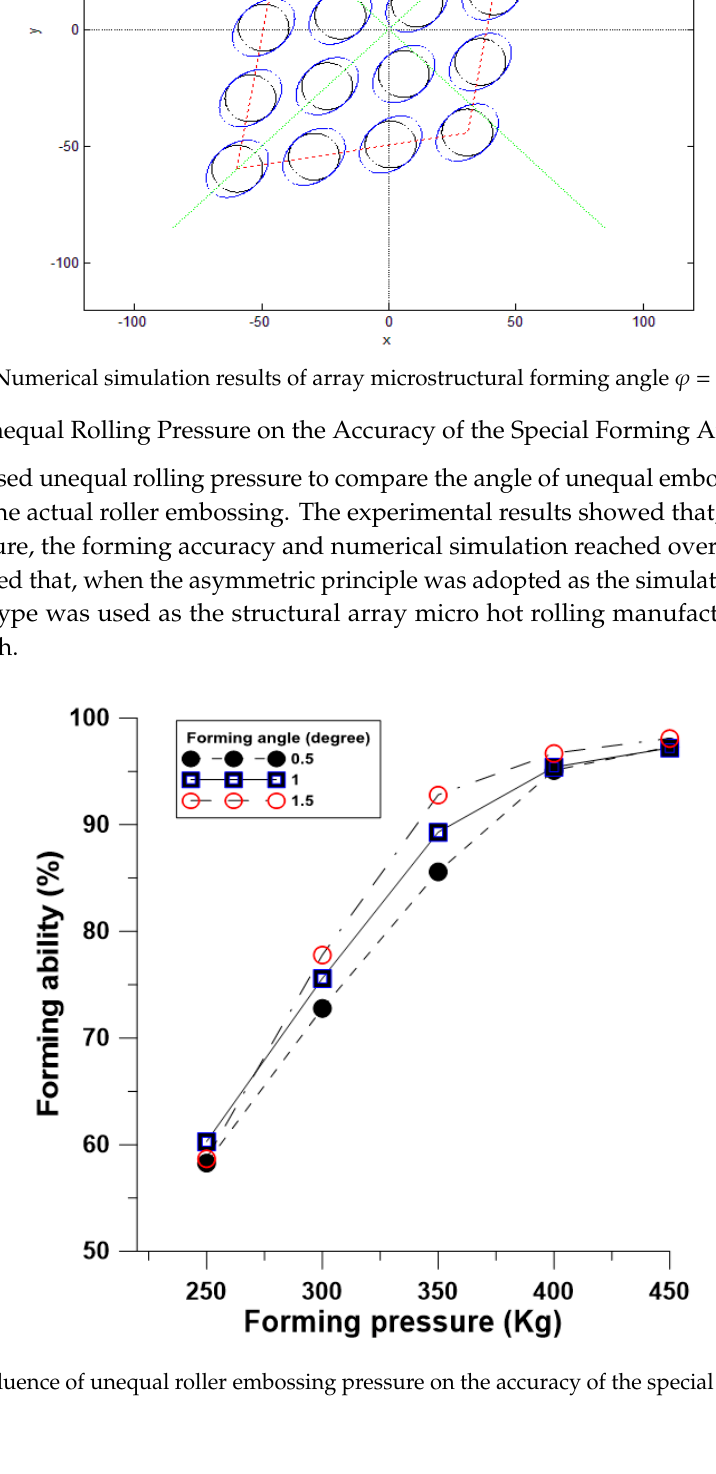
Figure 14. Numerical simulation results of single microstructural forming angle 𝜑 = 30°, 𝜃 = 20°.